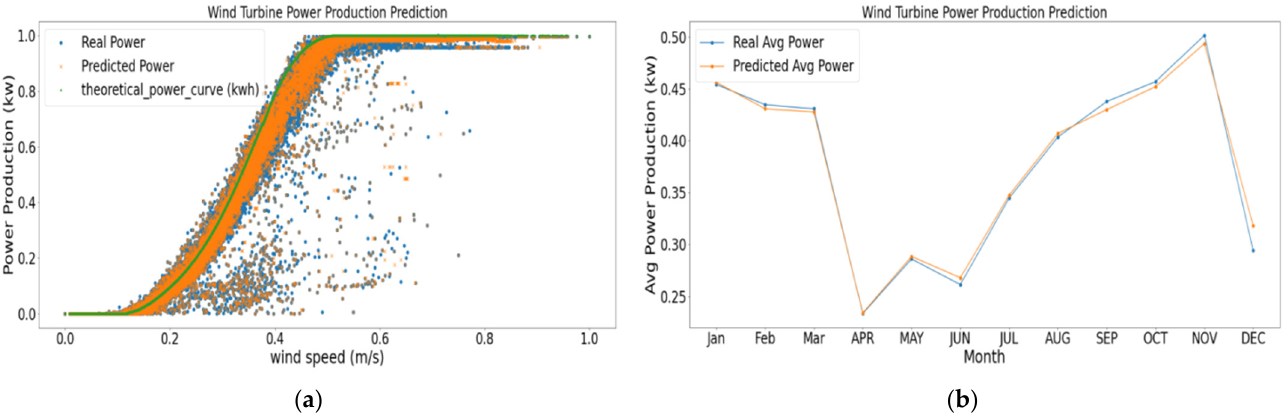
Figure 13. ( a ) Scatter plot depicting the relationship between the wind speed (m/s) and the power production (kW) of the turbine when using gradient boosting regression. ( b ) Predicted average power in comparison with the real average power of the turbine (kW) when using gradient boosting regression.